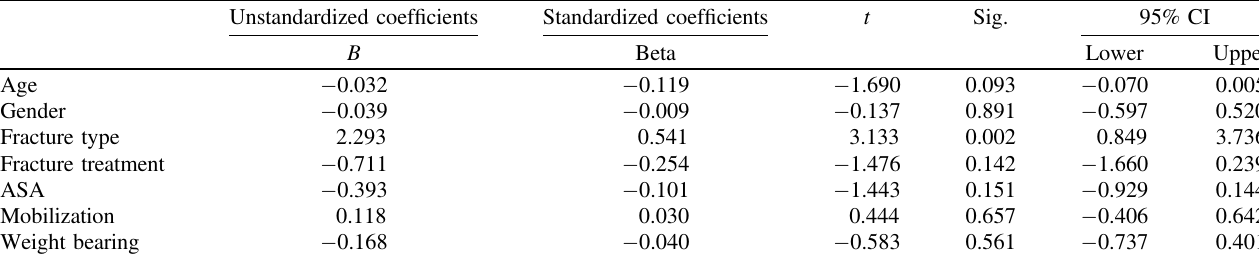
Table 7. Predictors for Merle d ’ Aubigné score. Unstandardized coef fi cients